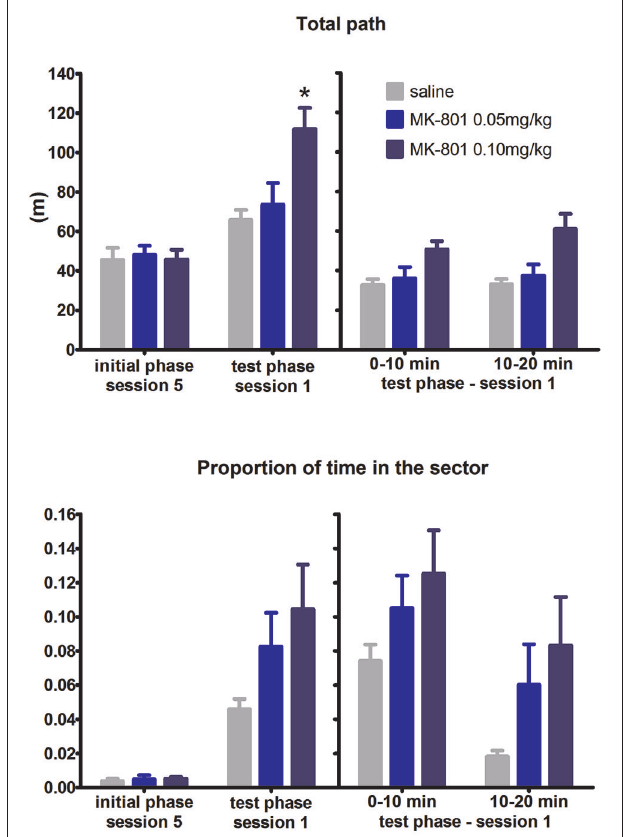
FIGURE 4 | Performance of the rats in condition 3 (set shifting: AF to RF switch) . Upper graph indicates total path elapsed during the last session of the initial phase, first session of the test phase, and its split into two 10 min segments (group means ± SEM). Lower graph shows proportion of session time spent in the prohibited sector. Difference between the session 1 of the test phase and the session 5 of the initial phase were computed as difference scores and the resulting statistics is provided. * P < 0.05 compared to saline group. Difference in time spent in the sector between MK-801 0.1 mg/kg and saline group was found significant when a two-way ANOVA was conducted on the whole test phase and Tukey’s post hoc test applied on significant MK-801 × SESSION interaction. However, this difference was not considered significant when using difference